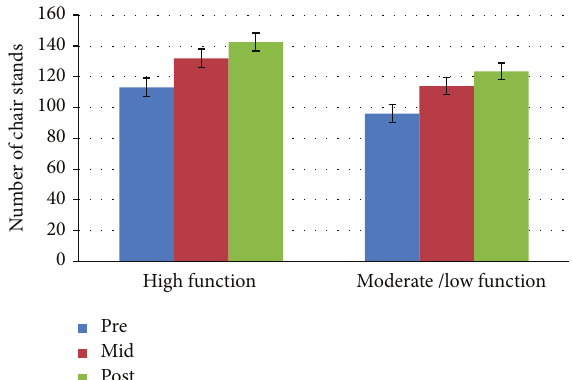
Figure 4: Chair sit-and-reach test mean scores by group and time.